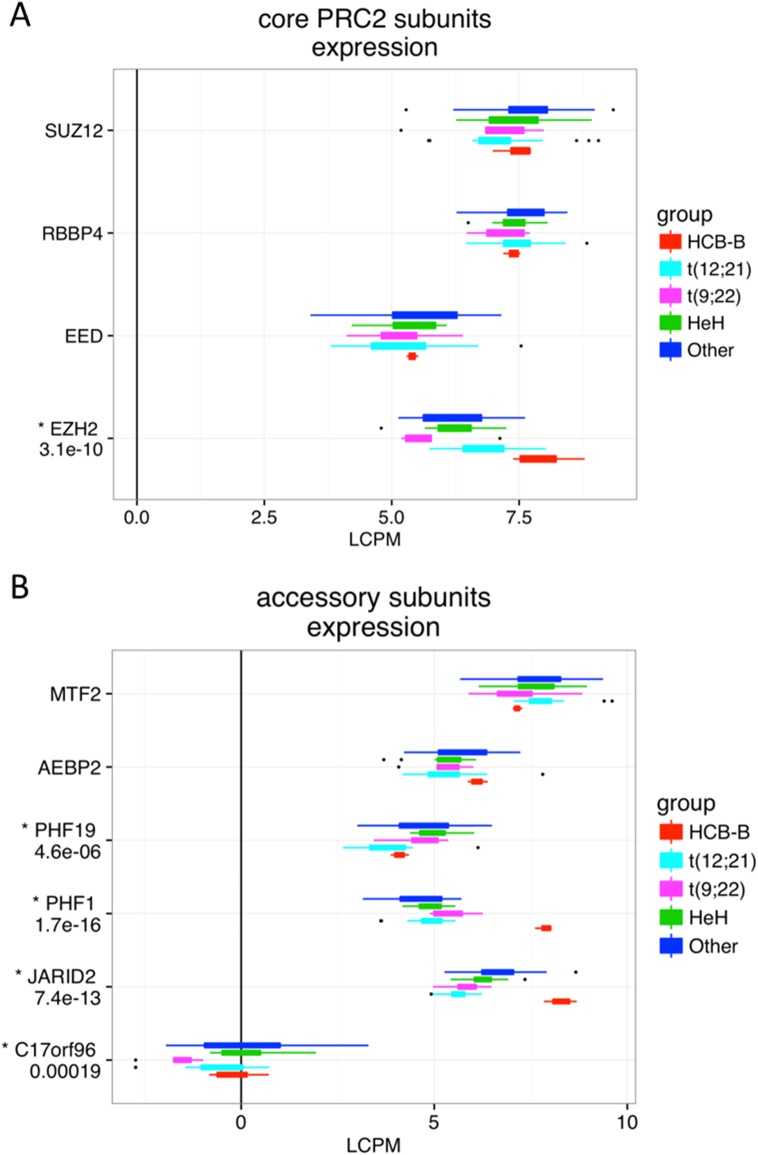
Expression distribution for core and accessory PRC2 subunits in our pre-B cALL cohort.Gene expression box plots for (A) core and (B) accessory PCR2 subunits. Thick boxes comprise observations from the first to the third quartiles in each group. Observations farther than 1.5*IQR (inter-quartile range) from these boxes boundaries are represented as dots. Genes identified as dysregulated by the edgeR analysis (FDR<1e-3) are marked with an asterisk and associated FDR values specified underneath.